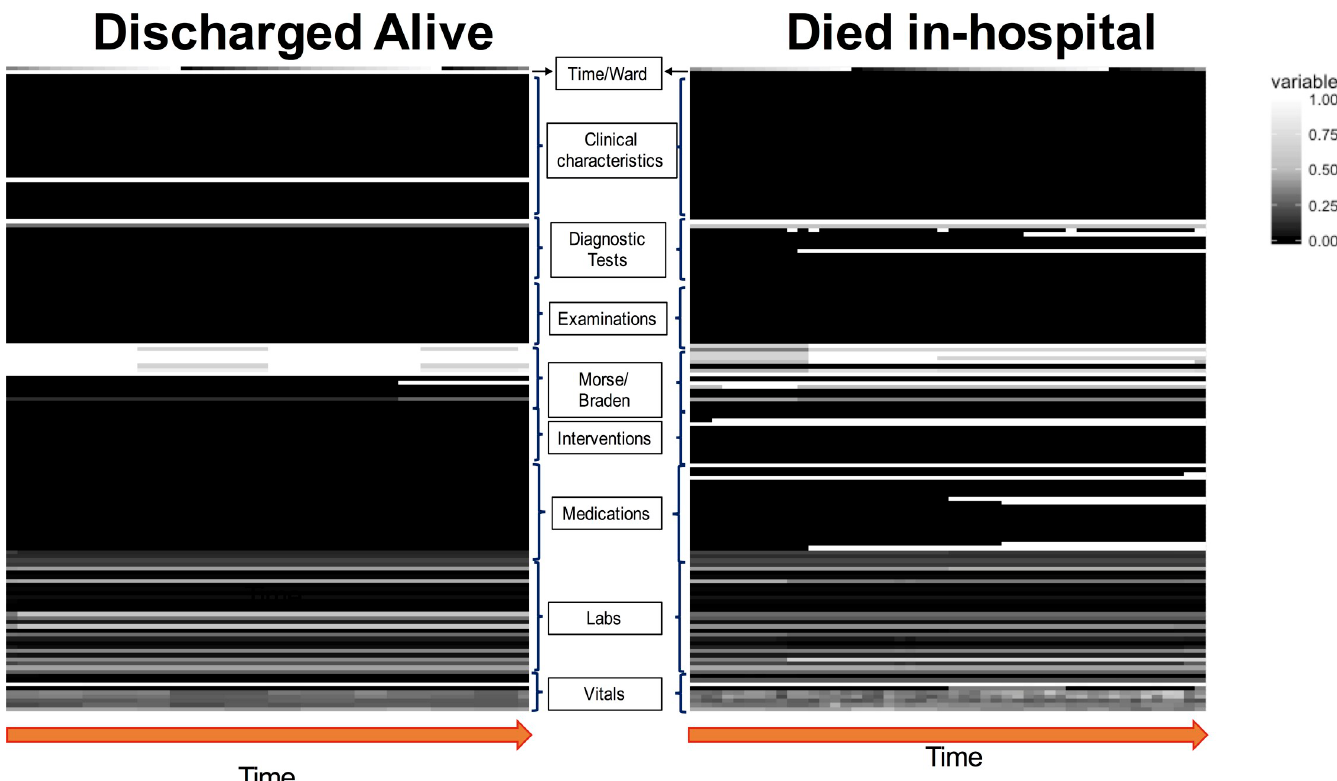
Fig 2. Visual timelines of two patients, one who was discharged alive (left) and one died during hospital stay (right). Time from admission (0–48 hours) is on the x-axis and variables grouped by category are on the y-axis. Continuous variables (e.g. temperature) are normalized so that black indicates minimum and white indicates maximum values. Binary variables (e.g. vasopressor medication) are represented so that black indicates absence and white indicates presence of the variable. As shown, the visual timeline of the patient who died depicts increased activity in the intervention and medication areas as well as multiple changes to vital sign readings as compared to the visual timeline of the patient who was survived the